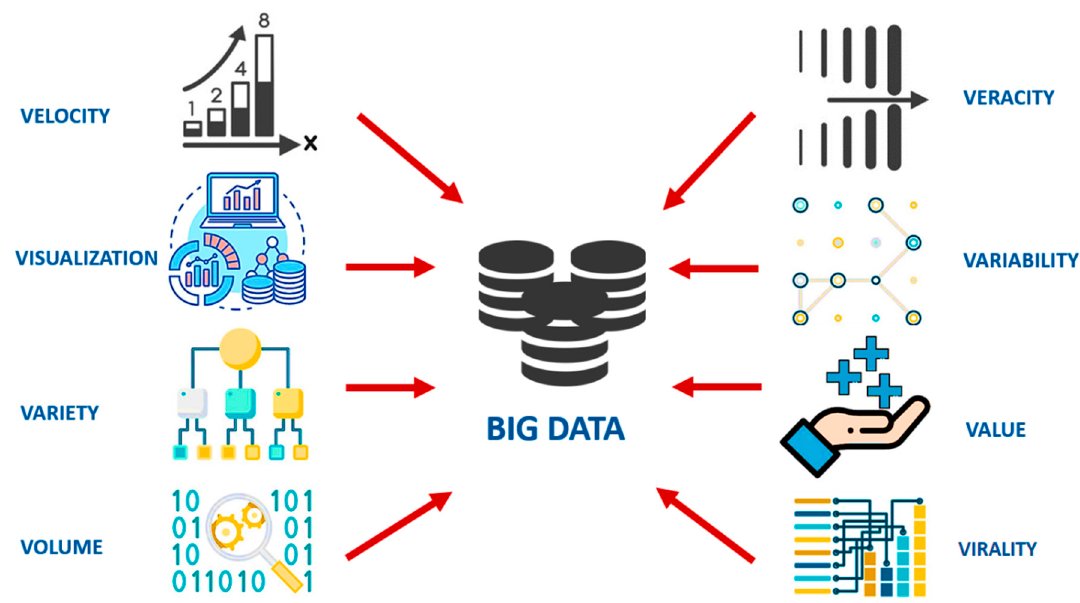
Figure 1. Representation of distinct dimensions of big data.